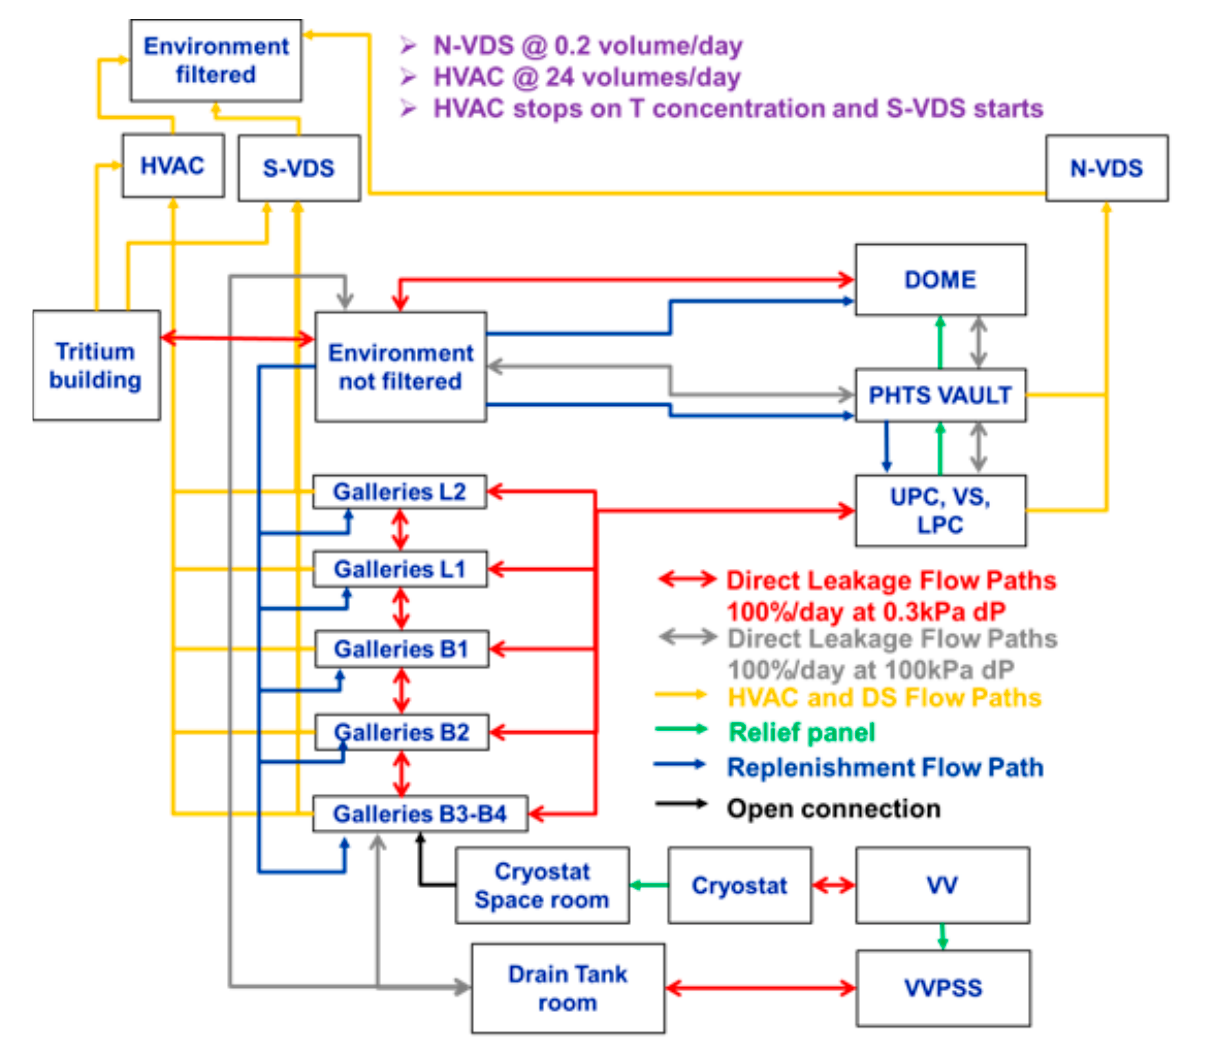
Figure 6. Dynamic Confinement MELCOR model.